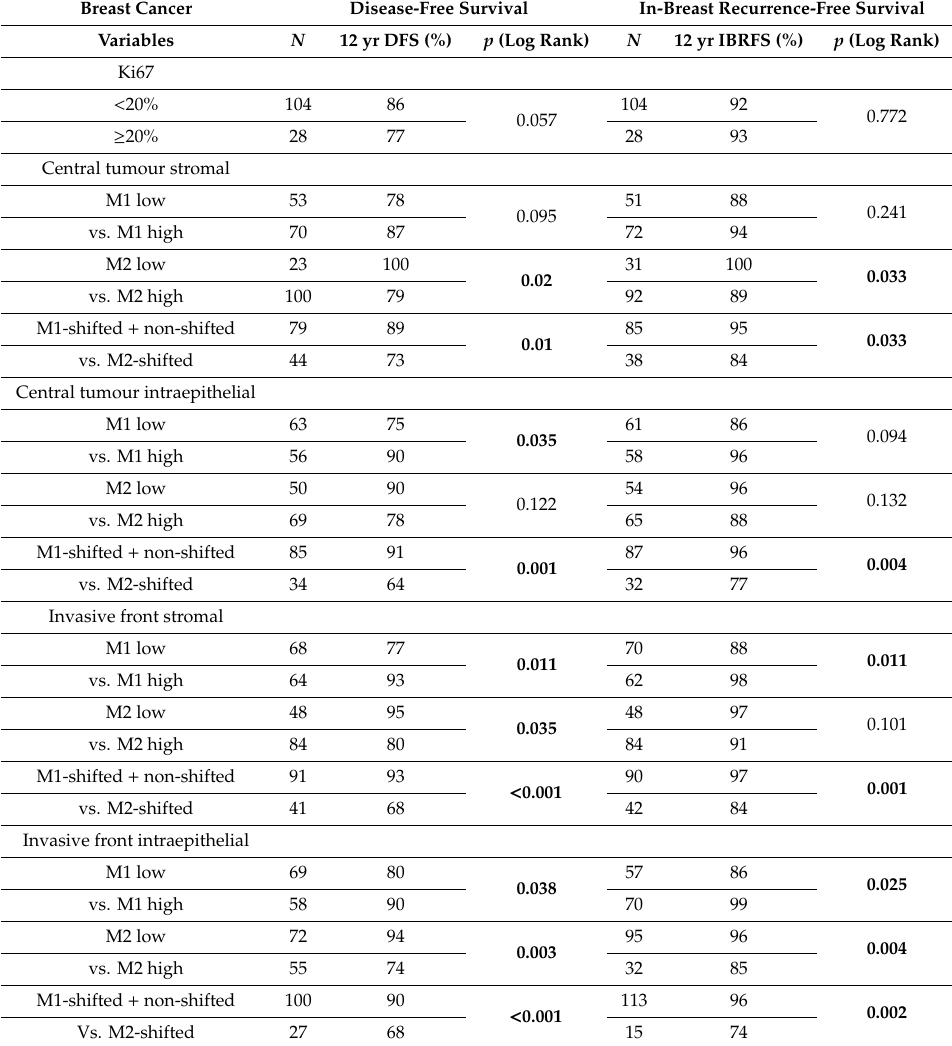
Table 3. Summary of 12-year survival according to Ki67, macrophage densities and macrophage shift classifications. Cut-o ff points for low vs. high macrophage densities for disease-free survival and in-breast recurrence-free survival can be found in the respective Kaplan–Meier